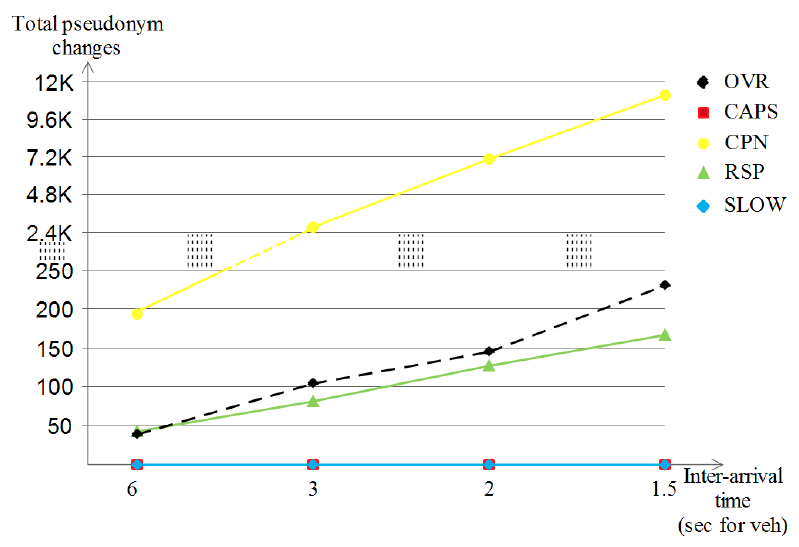
Figure 20. Pseudonyms consumption of privacy schemes in the highway